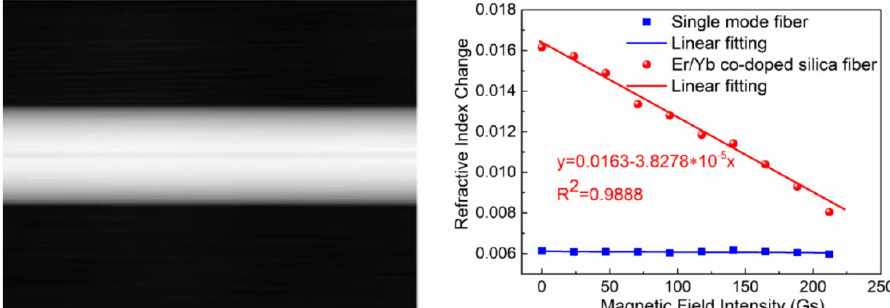
Figure 15. Two-dimensional phase distribution of experimental hologram, and a relationship between magnetic field and ERI based on an EYDF (reprinted with permission from Ref. [108], 2021, IEEE).